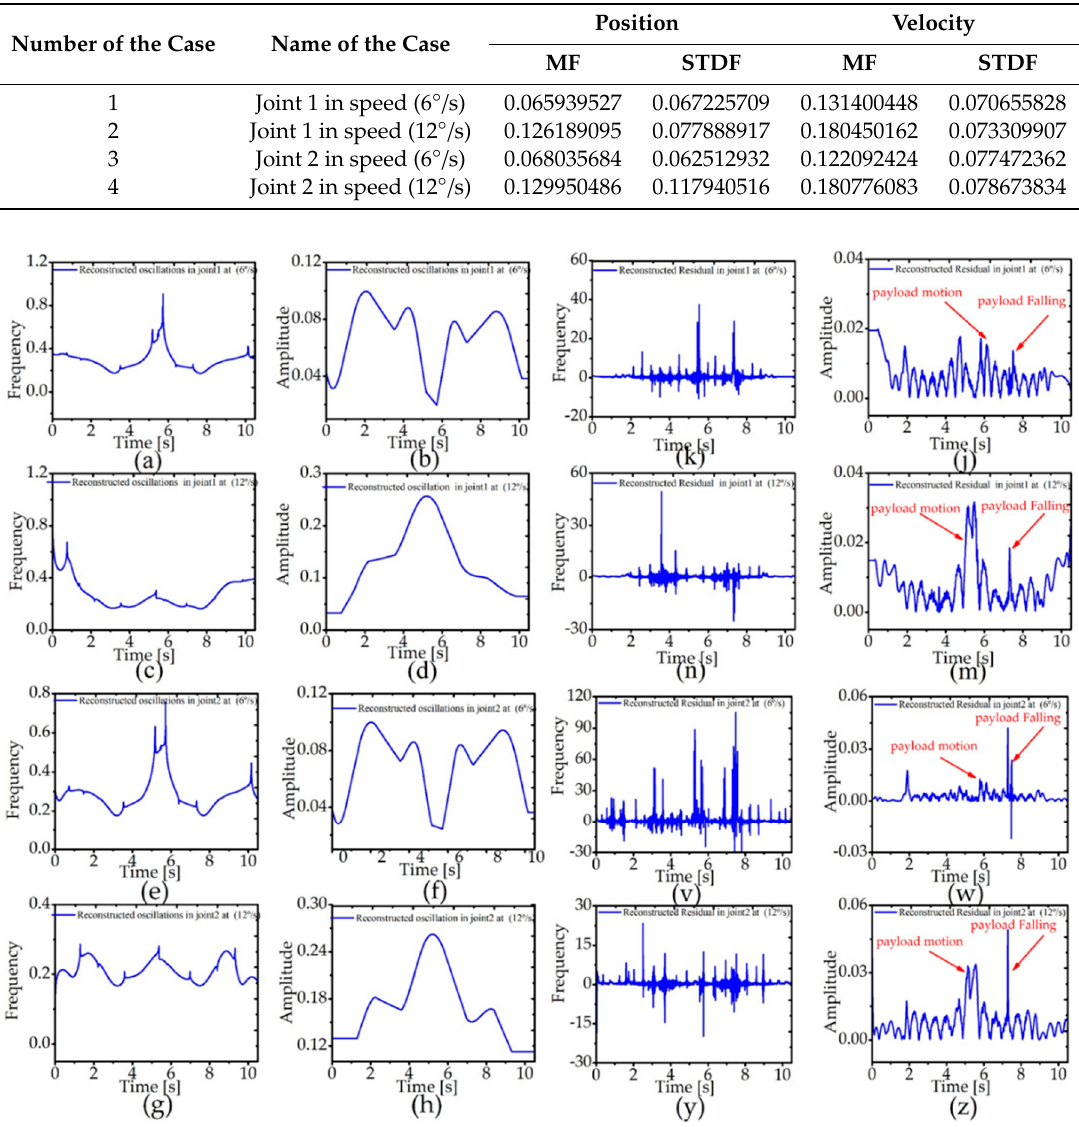
Figure 17. The IA and IF of position for both oscillations and residual at two speeds. Case 1: ( a ) IF of oscillations in joint 1 at 6 ◦ / s, ( b ) IA of oscillations in joint 1 at 6 ◦ / s, ( k ) IF of residual in joint 1 at 6 ◦ / s, ( j ) IA of residual in joint 1 at 6 ◦ / s, Case 2: ( c ) IF of oscillations in joint 1 at 12 ◦ / s, ( d ) IA of oscillations in joint 1 at 12 ◦ / s, ( n ) IF of residual in joint 1 at 12 ◦ / s, ( m ) IA of residual in joint 1 at 12 ◦ / s, Case 3: ( e ) IF of oscillations in joint 2 at 6 ◦ / s, ( f ) IA of oscillations in joint 2 at 6 ◦ / s, ( v ) IF of residual in joint 2 at 6 ◦ / s, ( w ) IA of residual in joint 2 at 6 ◦ / s, Case 4: ( g ) IF of oscillations in joint 2 at 12 ◦ / s, ( h ) IA of oscillations in joint 2 at 12 ◦ / s, ( y ) IF of residual in joint 2 at 12 ◦ / s, ( z ) IA of residual in joint 2 at 12 ◦ /